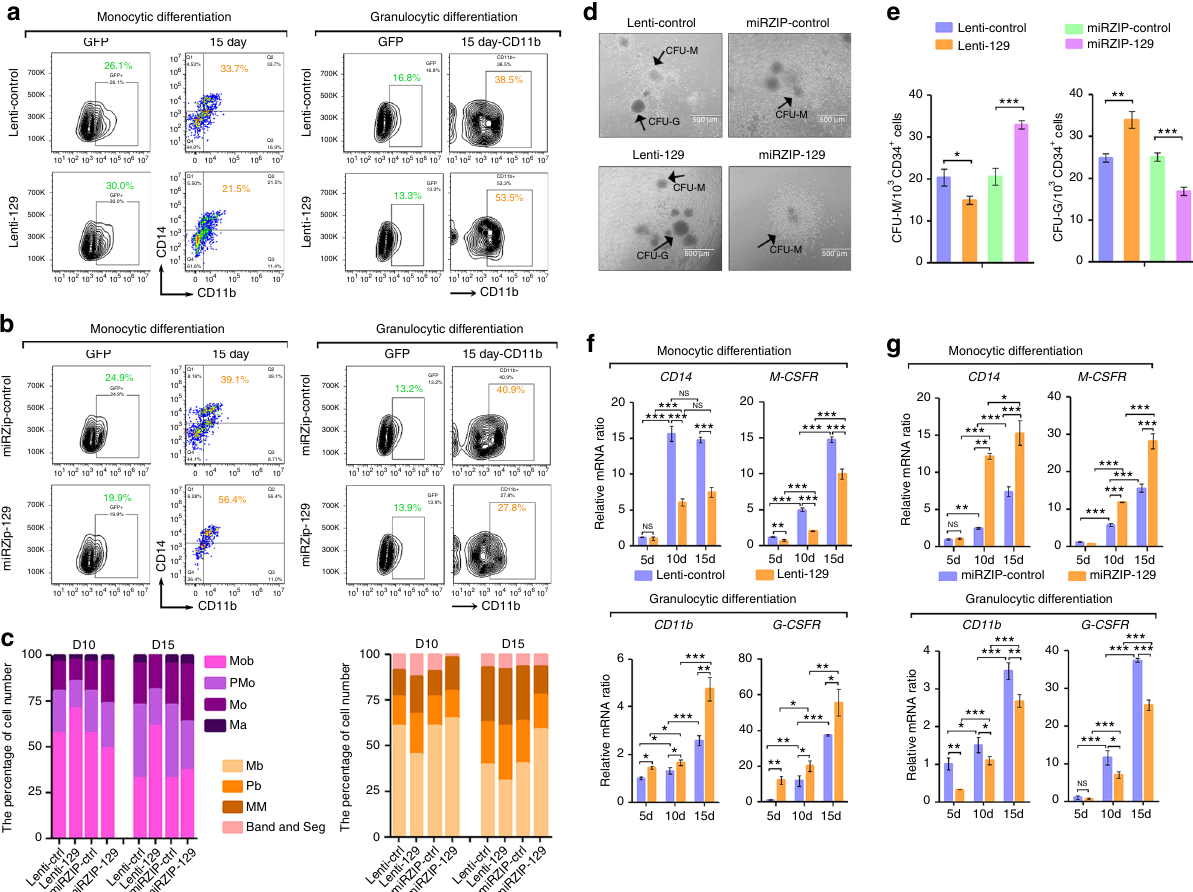
Fig. 8 miR-129 regulates monocytic and granulocytic differentiation. a , b CD34 + HPCs were transduced with lenti-129 or lenti-control a or miRZIP-129 or miRZIP-control b for 24 h, and then cultured for 15 days to allow cells to differentiate into monocytes or granulocytes. FACS analysis of the CD14 + /CD11b + and CD11b + populations of GFP-positive cells on day 15. c Quanti fi cation of Giemsa staining. d Colony-forming assay of CD34 + HPCs transduced with lenti- 129, miRZIP-129 or their controls. The bar represents 100 μ m. e The statistical analysis of the colony numbers shown in d . Three technical replicates from a single experiment. f , g qPCR analysis of the monocyte-granulocyte markers at the indicated times after miR-129 overexpression f or miR-129 knockdown g in CD34 + HPCs undergoing monocytic (upper) and granulocytic (lower) differentiation. Three technical replicates from a single experiment. Data are shown as means ± s.d. * P < 0.05, ** P < 0.01, *** P < 0.001, Student ’ s t